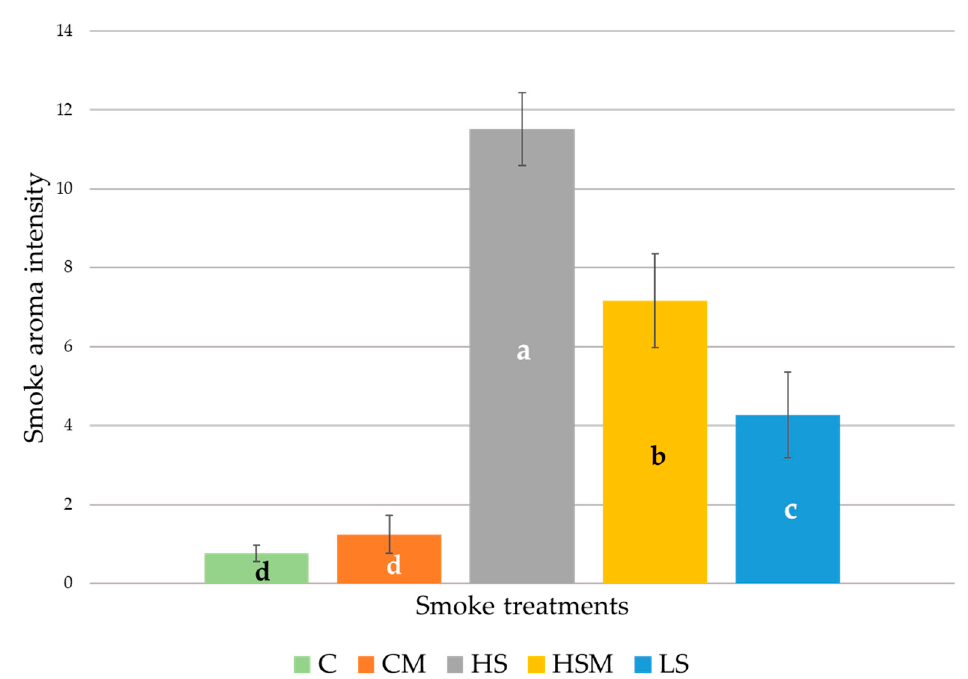
Figure 1. Mean values of smoke aroma intensities as rated using a 15 cm intensity scale with the letters of significance from the ANOVA and Fisher least significant difference (LSD) post hoc test ( p < 0.05; α = 0.05). Abbreviations: C = control, CM = control with in-canopy misting, HS = high-density smoke exposure, HSM = high-density smoke exposure with in-canopy misting, LS = low-density smoke exposure, SE = standard error.